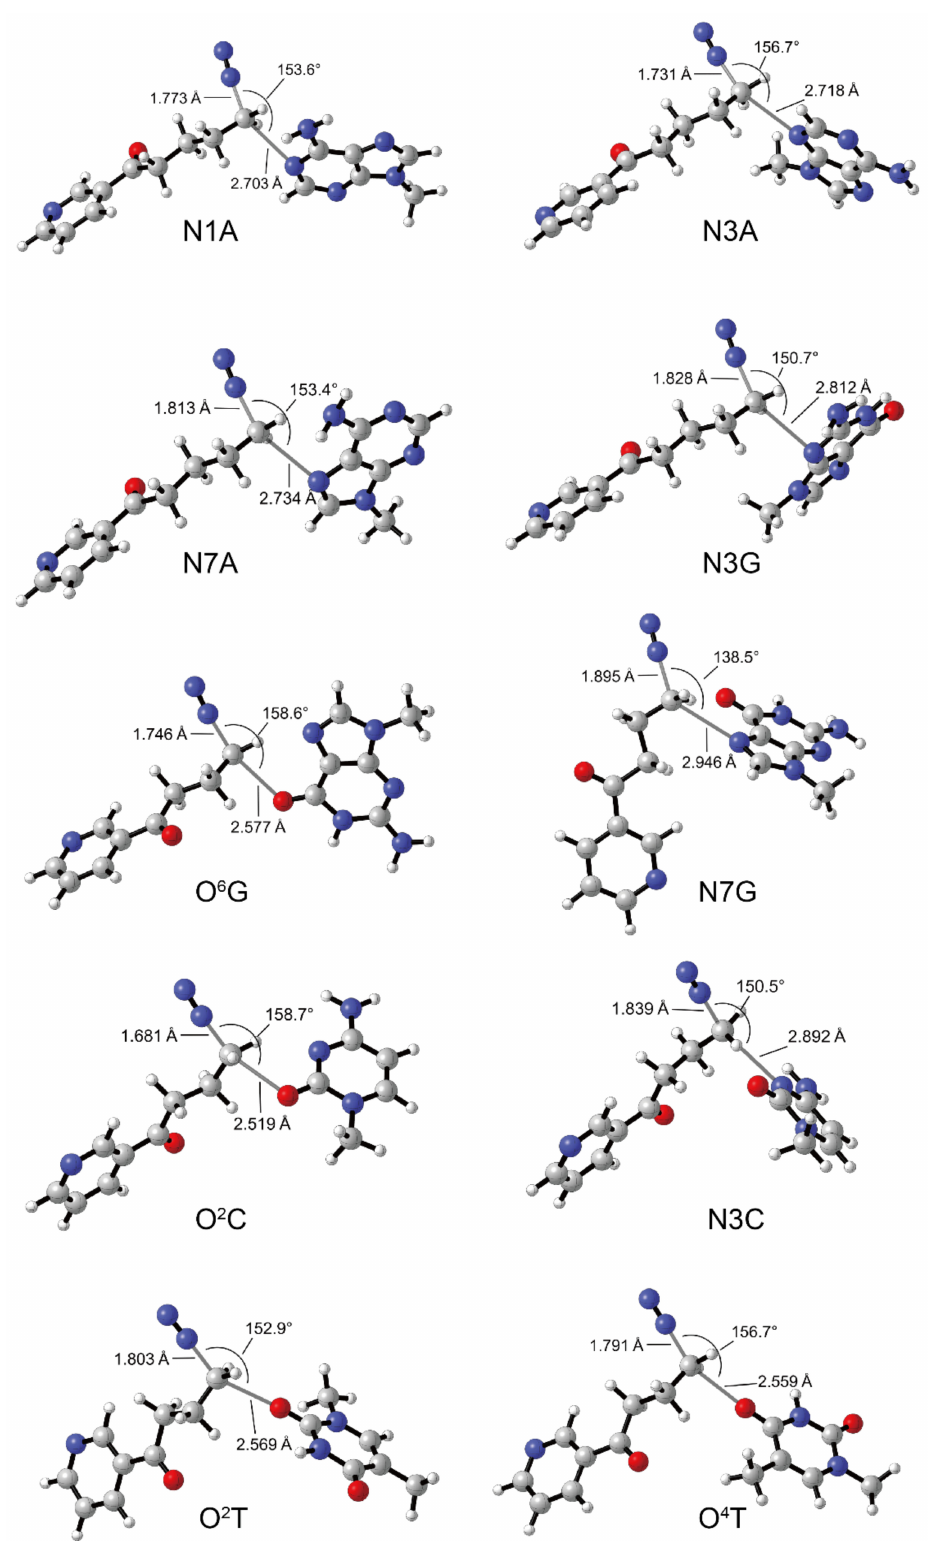
Figure 5. Optimized geometries and main parameters of the transition states for alkylation reactions with ten DNA base sites induced by the diazonium ions generated from 2 (cid:48) -hydroxylation of NNN. N1A = N1 position of adenine; N3A = N3 position of adenine; N7A = N7 position of adenine; N3G = N3 position of guanine; O 6 G = O 6 position of guanine; N7G = N7 position of guanine; O 2 C = O 2 position of cytosine; N3C = N3 position of cytosine; O 2 T = O 2 position of thymine; O 4 T = O 4 position of